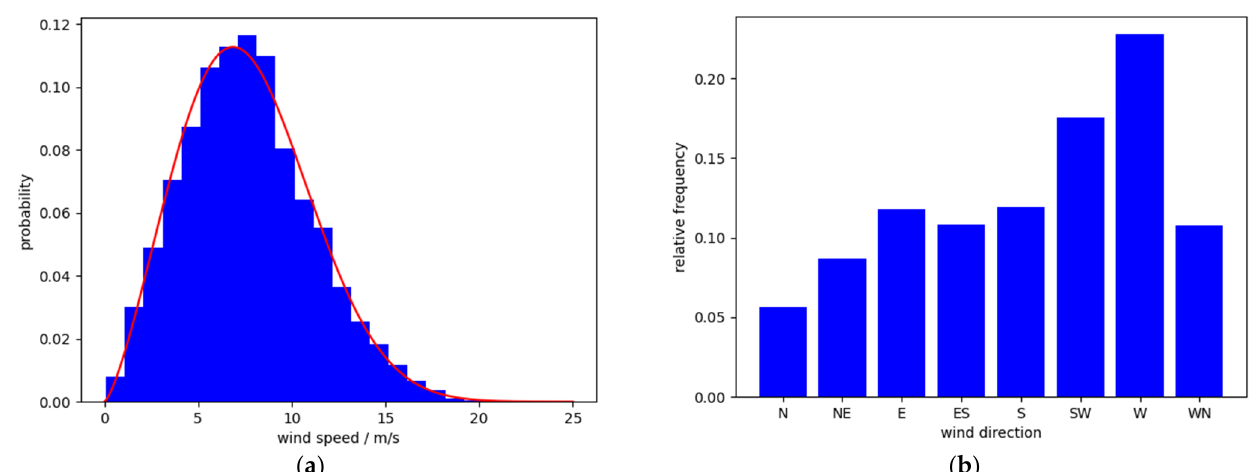
Figure 6. ( a ) Histogram (blue columns) of the wind speed for the wind direction east, together with fitted probability density function of the Weibull distribution (red curve). ( b ) Distribution of the wind direction subdivided in eight directions, from north (N), north east (NE), …, to west north (WN) [43].